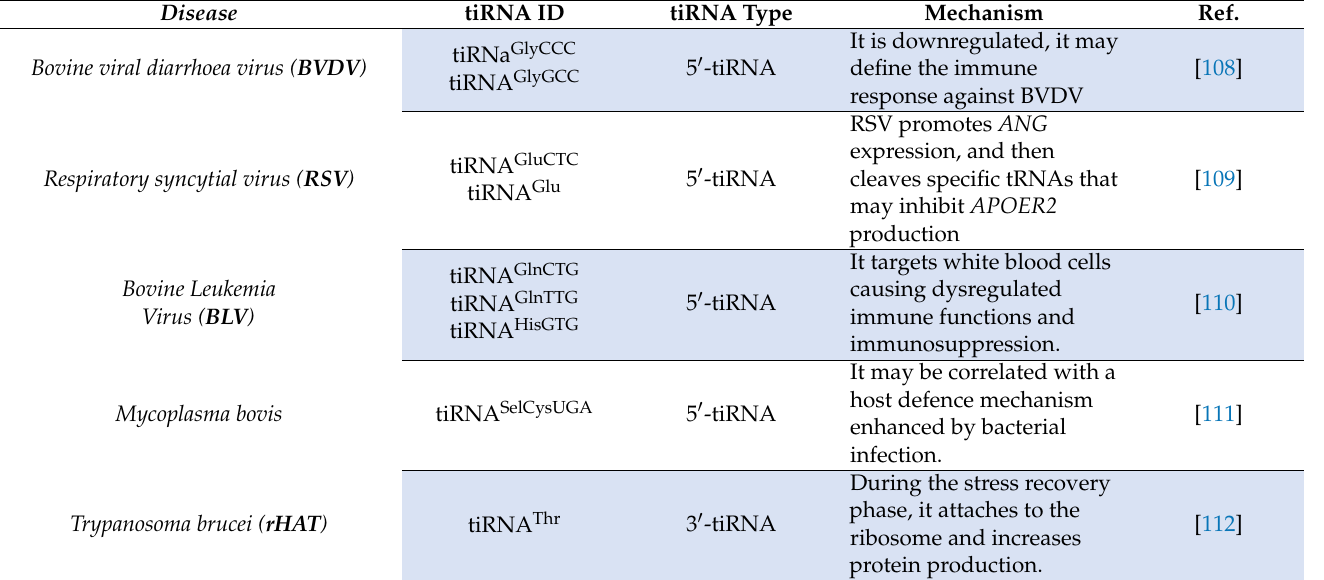
Table 4. tiRNAs involved in some human and farm animal infectious